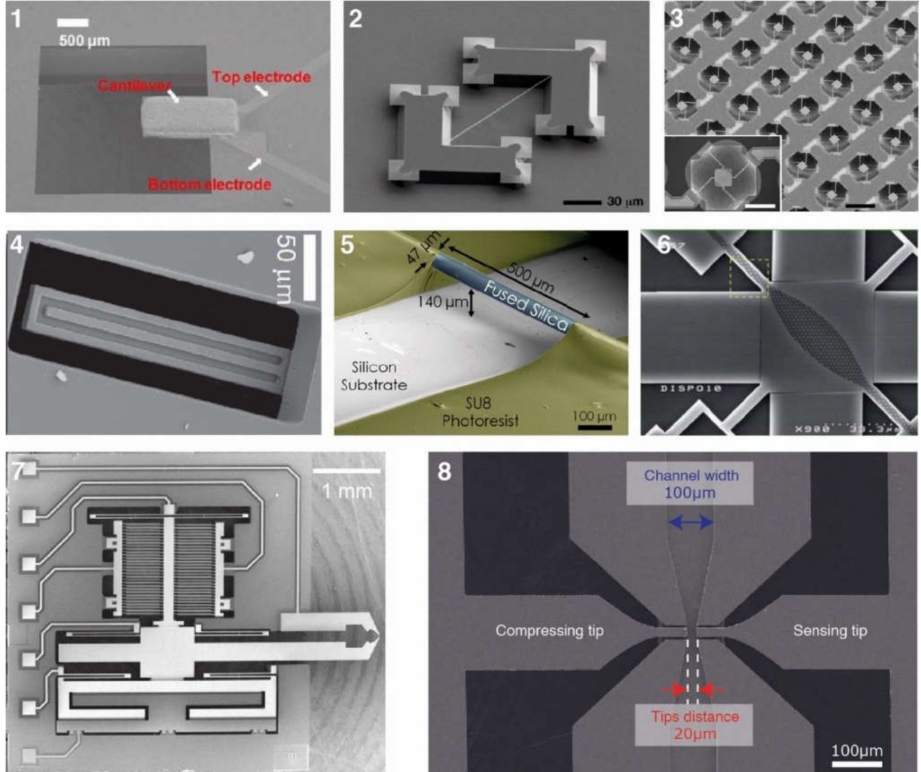
Figure 1. Examples of different types of silicon-based resonant MEMS applied at the subcellular level. 1–3 are suspended structures of ( 1 ) cantilever type (reproduced from [61], with the permission of AIP publishing), ( 2 ) bridging type [62] (Copyright Elsevier 2008), and ( 3 ) plate type [12] (with granted permission from PNAS). Structures 4 to 6 have integrated channels as in the cases of ( 4 ) cantilever type [11] (reprinted by permission from Springer Nature [11] Copyright 2007), ( 5 ) bridging type [63] (reproduced with a permission from ACS), and ( 6 ) plate type [64] (reproduced with permission from The Royal Society of Chemistry). MEMS squeezers include ( 7 ) microgrippers [57] (CC BY license) and ( 8 ) fluidics-integrated devices [65] (CC BY